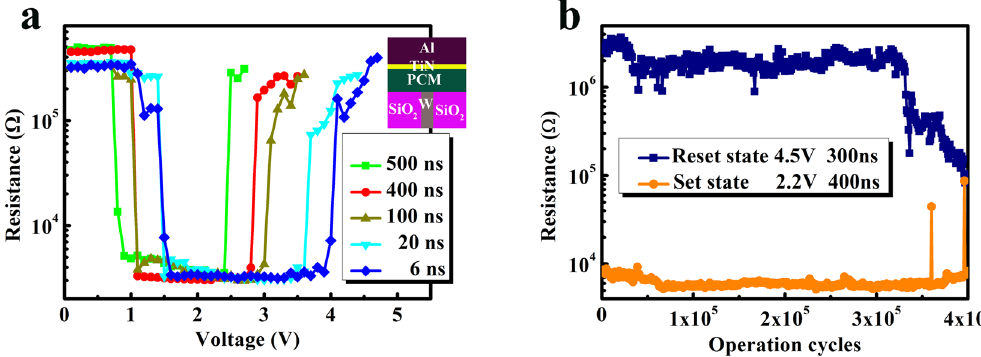
Figure 4. ( a ) Resistance-Voltage characteristics of Sc 0.1 Sb 2 Te based PCRAM device with difference voltage pulse widths. The inset depicts the schematic diagram of the T-shaped PCRAM cell structure. ( b ) Reversible switching characteristic of the device.